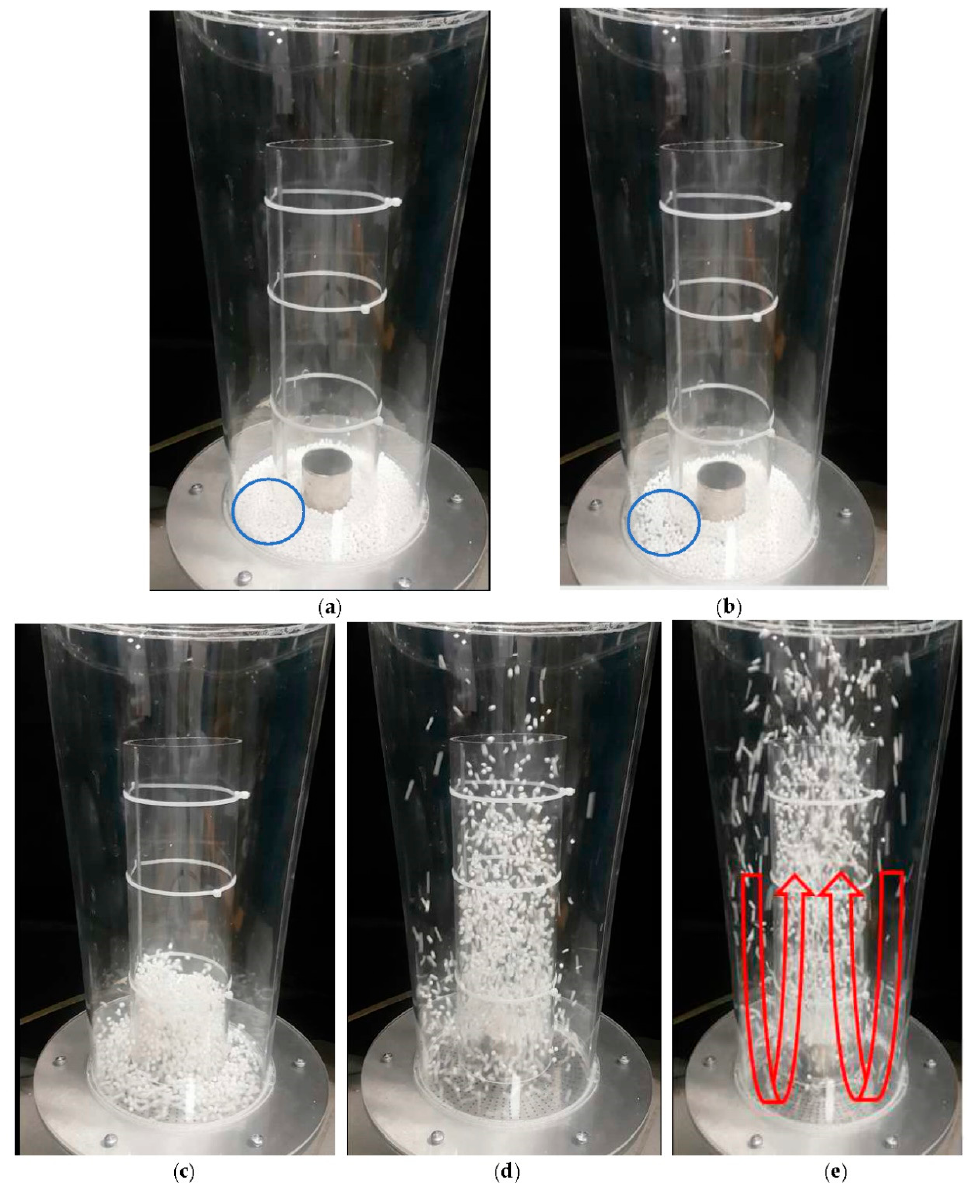
Figure 3. Regimes of fluidization of alginate aerogel particles in the Wurster fluidized bed with 150 mL batch volume, 2 cm partition gap height and the wide tube. ( a ) There was no air flow inside the bed. ( b ) Minimum fluidization (the minimum fluidization air velocity: 0.19 ± 0.01 m/s). Blue circled area represents particle behavior at minimum fluidization velocity. They started vibrating and bed porosity increased in comparison to same blue circled area in ( a ). ( c ) Bubbling phase. ( d ) Turbulent flow. Lean and dispersed particle movement at the outlet of the tube. ( e ) The U-shaped trajectory of particles with a circulatory motion (superficial velocity: 2.4 ± 0.1 m/s).